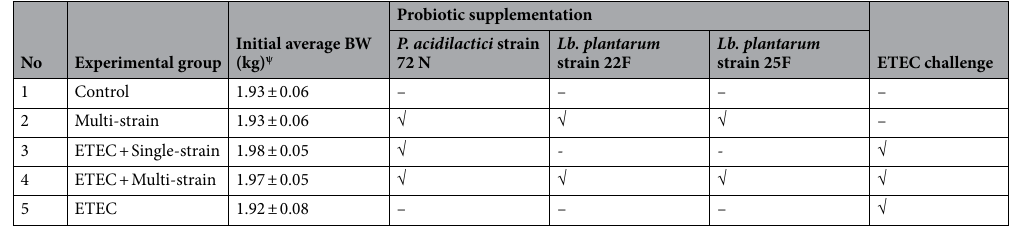
Table 2. Initial average bodyweight and summary of the experimental groups. √ and—represent with and without supplementation or challenge, respectively. ψ Values are presented as mean ± SEM.